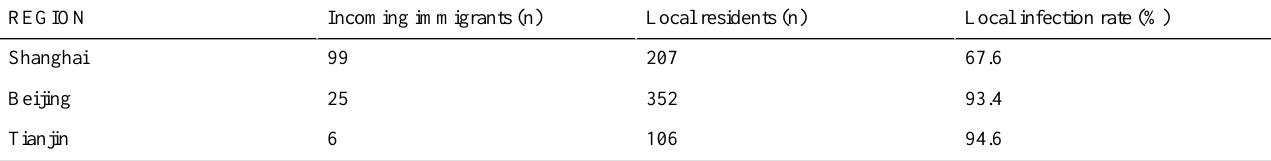
Table 4. Basic reproduction numbers for 6 REGIONs on February 10, 2020.